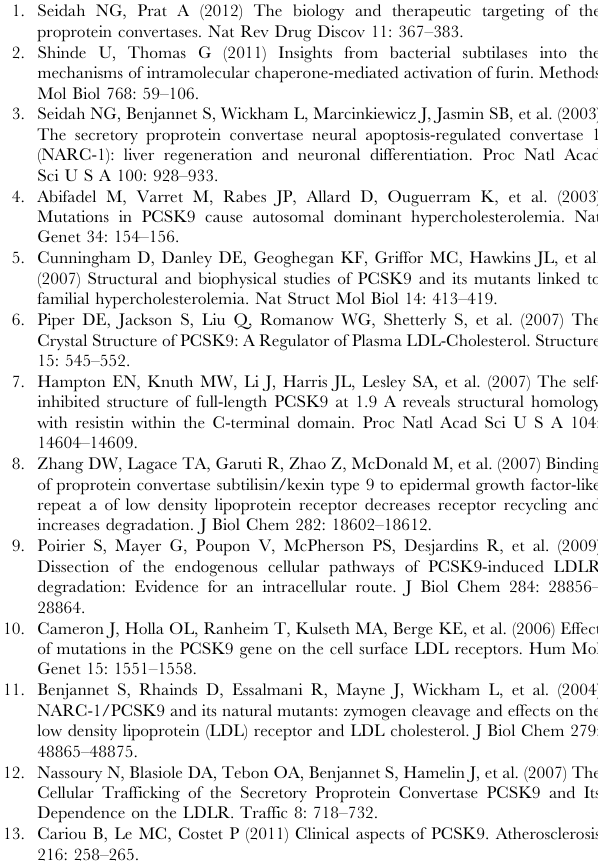
PCSK9, L455X and CHRD proteins were detected using a monoclonal horseradish peroxydase conjugated-V5 antibody. These data are representative of at least three independent experiments. Figure S2 Similar inhibitory effect on LDLR degrada- tion induced by PCSK9 when co-expressed with Fcpro or Fcpro QH. Cell lysates of HEK293 cells co-expressing Fcpro or Fcpro QH with human wild type PCSK9 were resolved by 10% SDS-PAGE. Total LDLR levels were analyzed by Western blot and LDLR proteins were detected by using a polyclonal anti- human LDLR antibody and its levels were normalized relative to b -actin cellular loading controls. pIR: control empty pIRES vector. Figure S3 Pull-down of PCSK9 by Fcpro or Fcpro QH chimeras in HepG2/shPCSK9 cells. Cell lysates of HepG2/ shPCSK9 cells co-expressing Fc or Fcpro or Fcpro QH with a full length PCSK9 or a PCSK9 D prosegment were immunoprecipitat- ed (IP) with an anti-PCSK9 prosegment antibody and the immunoprecipitates were resolved by 12% SDS-PAGE and analyzed by Western blot using a monoclonal horseradish peroxydase conjugated-V5 antibody (IB:V5). The migration positions of the zymogen of PCSK9 (proPCSK9) and PCSK9 are shown. This figure is representative of at least two independent experiments. pIR: control empty pIRES vector. (TIF)